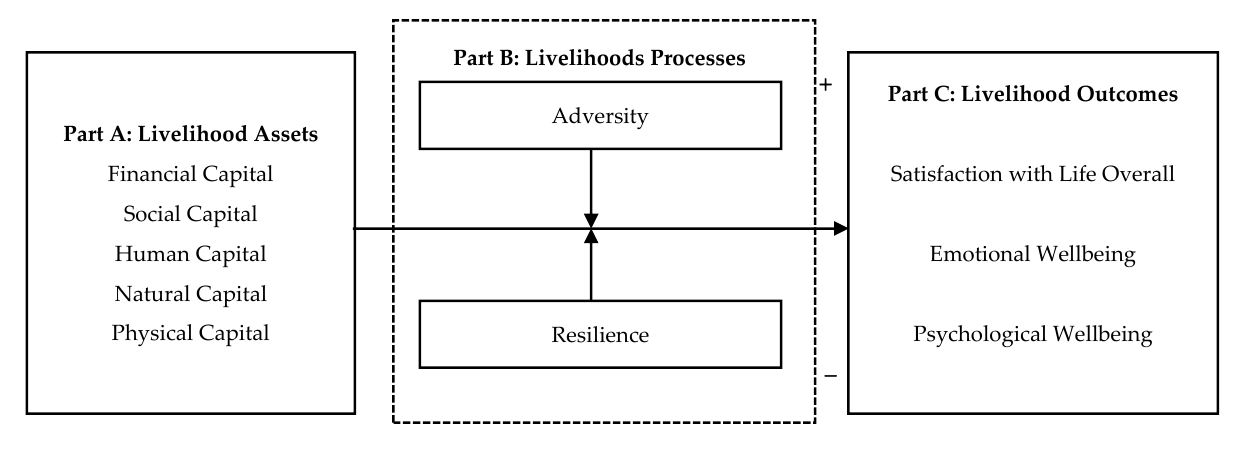
Figure 1. The conceptual model.